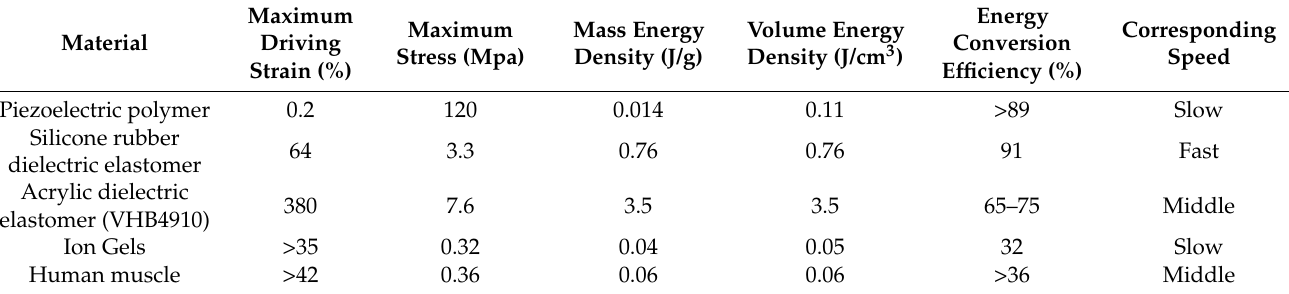
Table 1. Several different flexible material data